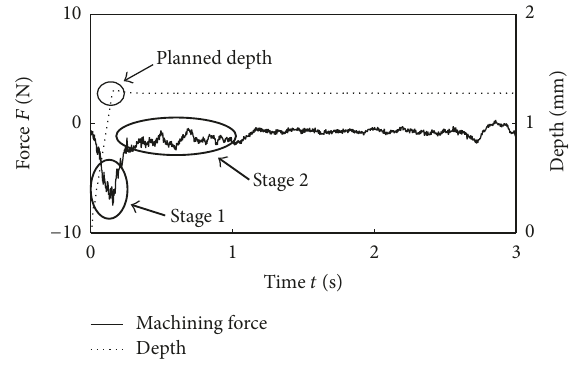
Figure 2: Deformation release process.